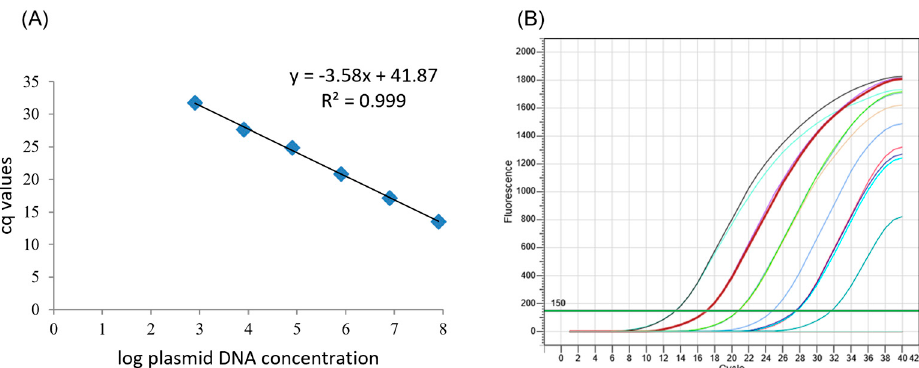
Figure 3. Calibration curve obtained with the Fusarium spp.-specific qPCR TaqMan ® assay showing copy number of template vs. quantification cycle (Cq). ( A ) Calibration curve constructed based on Cq values obtained from the log of ten-fold dilution series of target plasmid DNA in the dynamic range of 8 × 10 2 to 8 × 10 7 target copies. ( B ) Amplification plot where the cycle number increases as target plasmid DNA concentration decreases. R 2 : regression coefficient.